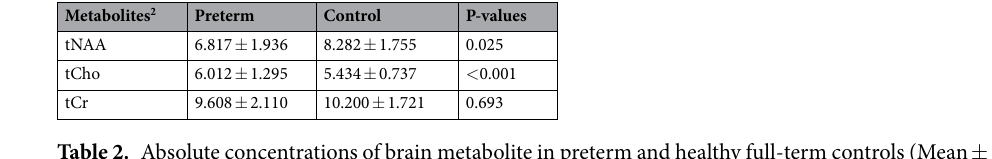
Table 2. Absolute concentrations of brain metabolite in preterm and healthy full-term controls (Mean ± SD) 1 . Legend: 1 controlling for GA at MRI; 2 concentration is in